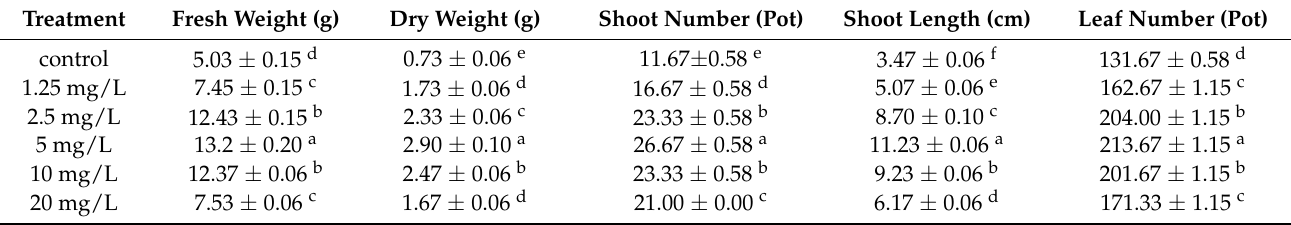
Table 1. Effect of zinc oxide nanoparticles on the in vitro regeneration of Maerua oblongifolia after 45 days of treatment in MS media.